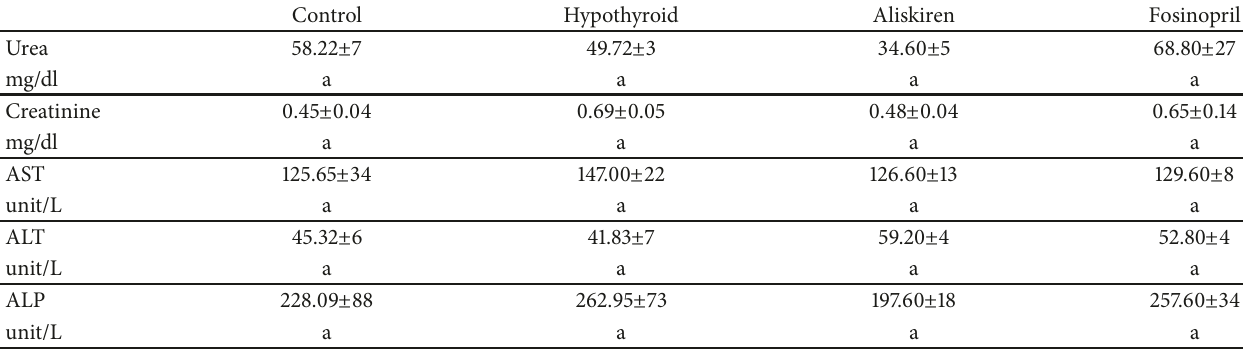
Table 7: Blood biochemistry tests in control, hypothyroid, Aliskiren, and Fosinopril groups.